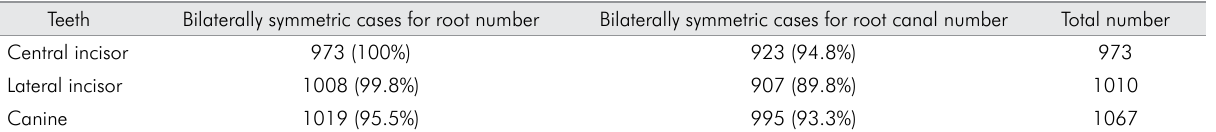
Table 3. Cases in which the number of roots or root canals is bilaterally symmetric. Total number represents the number of cases in which the tooth is contralaterally present in the mouth.